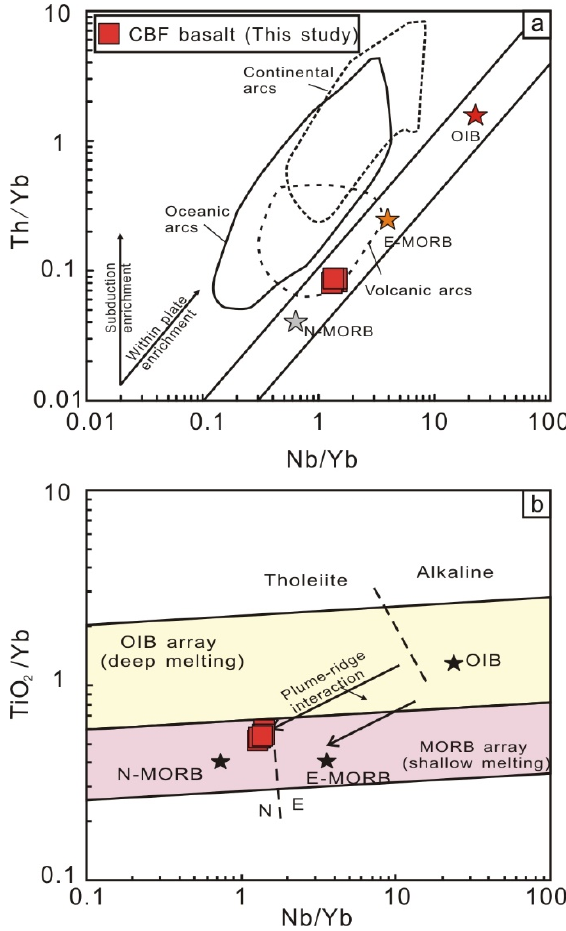
Figure 6. ( a ) Th/Yb vs. Nb/Yb and ( b ) TiO 2 /Yb vs. Nb/Yb discrimination diagrams for basalts from CBF in the WPB (modified after Reference [41]). ( a ) The compositional trends for subduction enrichment, crustal contamination, and within-plate enrichment are from Reference [41]. Abbreviations (in alphabetical order): E-MORB: enriched-type mid-ocean ridge basalt, N-MORB: normal-type mid-ocean ridge basalt, OIB: ocean island basalt, UM: upper mantle, Alk: alkaline, PM: primitive mantle, and Th: tholeiitic.